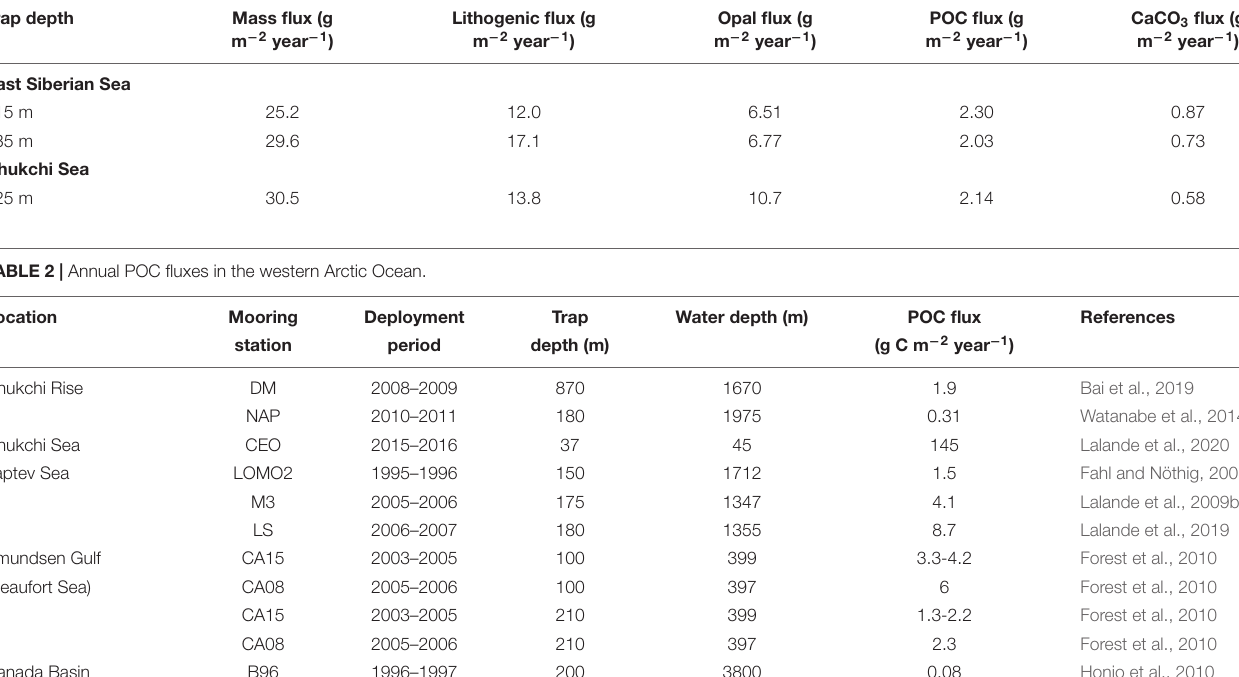
TABLE 1 | Annual fluxes of total mass flux, lithogenic flux, biogenic opal flux, POC flux, and CaCO 3 flux on the East Siberian Sea slope (KAMS 1) and the Chukchi Sea slope (KAMS 2) from August 2017 to July 2018 (348 days). Trap depth